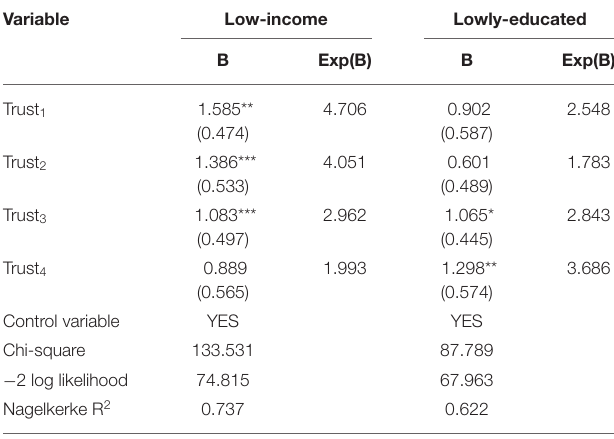
TABLE 5 | The cluster regression results.